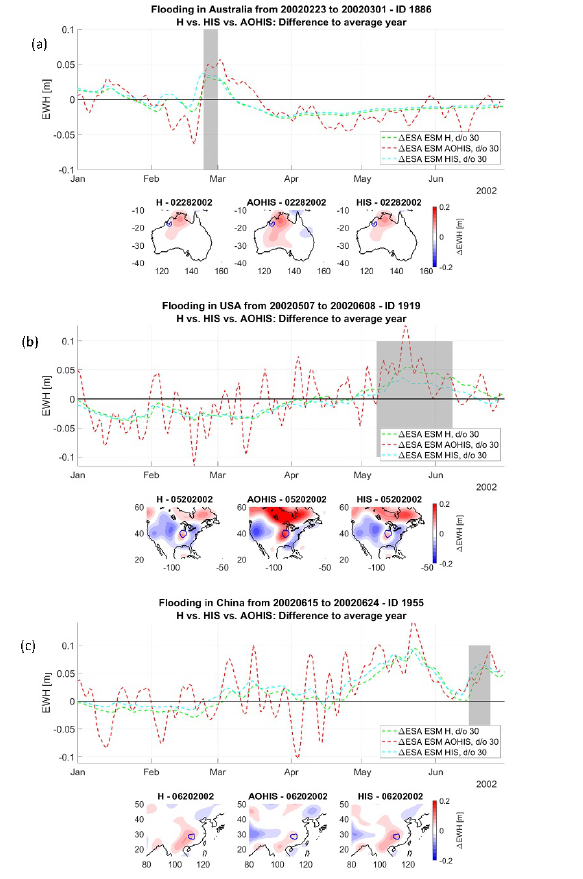
Fig. 3. The hydrology component of the ESA ESM displayed till d/o 100 (magenta), 50 (blue) and 30 (green) for the flood in Australia (a, ID 1886 according to the DFO), the US (b, ID 1919) and China (c, ID 1955). The duration of each flood is indicated with the grey shading. Below a spatial plot of the general affected area before and in the middle of the flood with d/o 100, 50 and 30 is visualized. As area of interest the affected area according to the DFO is used, also called floodzone.